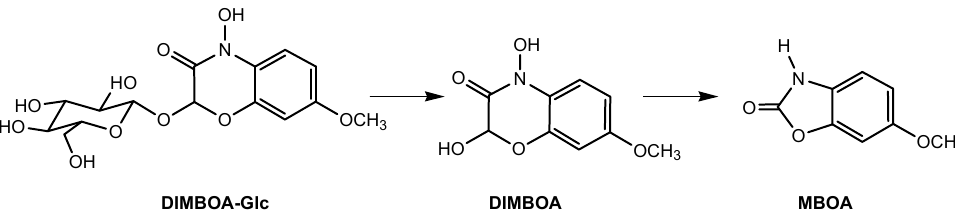
Figure 4. 2-(2,4-dihydroxy-7-methoxy-1,4-benzoxazin-3-one)- β -D-glucopyranose (DIMBOA-Glc) and its degradation products in soil.